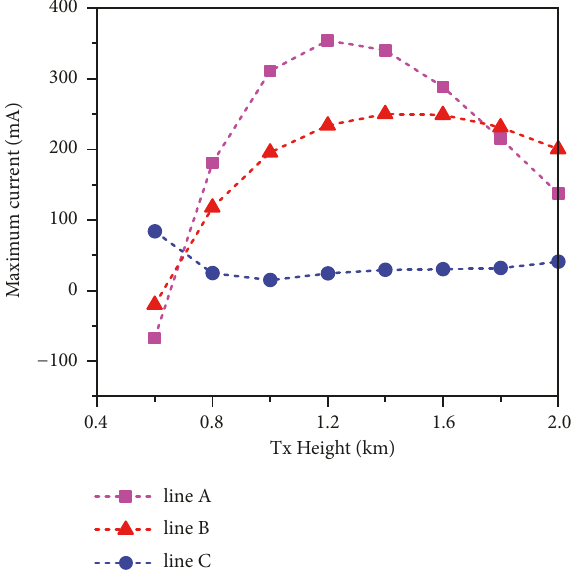
Figure 16: The maximum currentsat different transmitting antenna heights. The frequencies are 60 MHz, and conductor radii are 0.007